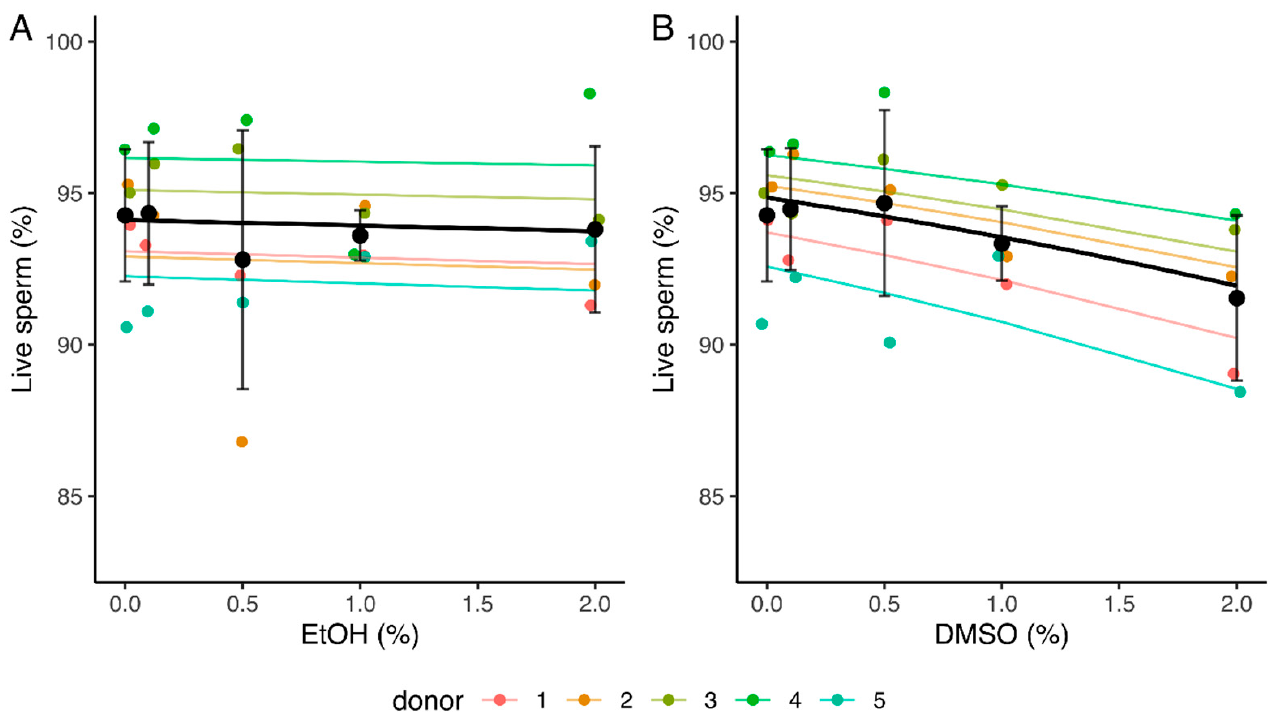
Figure 3. Influence of increasing concentrations of ethanol (EtOH) ( A ) and dimethyl sulfoxide (DMSO) ( B ) on sperm vitality after a 4 h incubation. Values for each replicate ( n = 5) are highlighted by a dot whose color refers to a donor. Colored lines represent the model fit for each donor. Black dots represent mean values for each concentration ± SD. Black lines correspond to the mean effect across all donors (Tables 2 and S3).